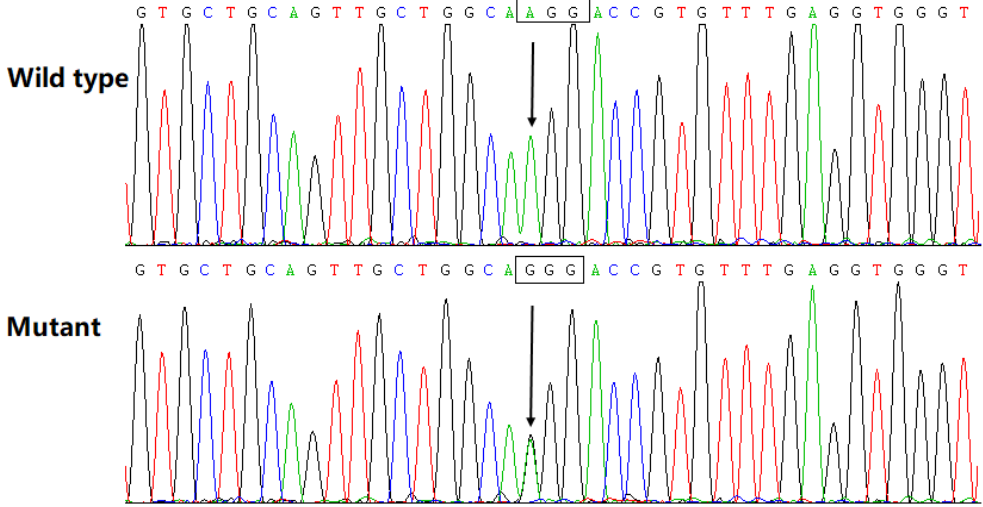
Figure 2. Sequence electropherograms exhibiting the wild-type and heterozygous c.550A>G-mutant Cx45 alleles. An arrow sign pinpoints the homozygous nucleotides of A/A in an unaffected subject (wild type) or the heterozygous nucleotides of A/G in the affected proband (mutant). A rectangle signal delimits a codon of Cx45 .